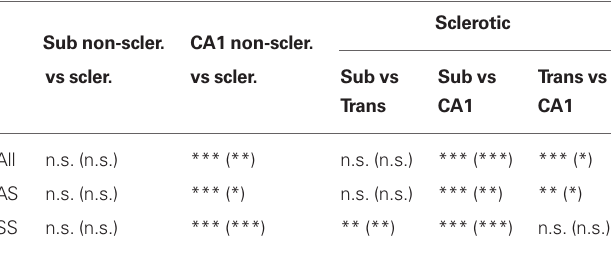
Table 3 | Statistical comparison of the synaptic densities between the different hippocampal fields.